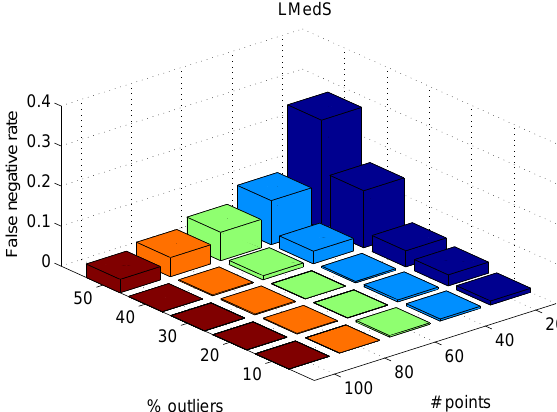
Figure 5: False negative rate vs percentage of outliers and number of points for the first part of the